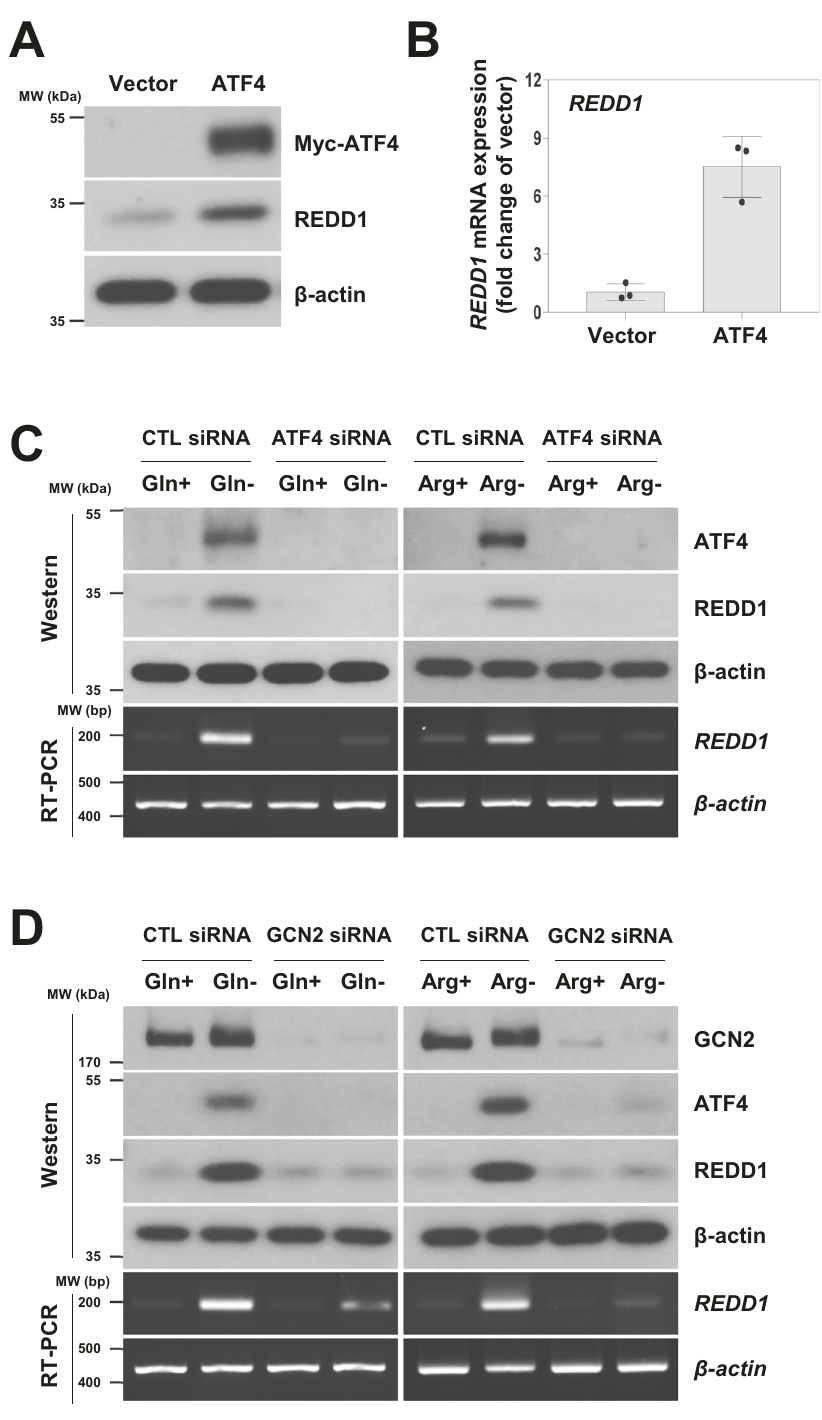
Fig. 2 The GCN2/ATF4 signaling pathway upregulates REDD1 expression upon glutamine or arginine deprivation. A , B H1299 cells were transiently transfected with an empty vector (pEF) or a myc-tagged mATF4 (ATF4) plasmid for 24 h. The indicated protein and mRNA expression levels were measured by western blot and real-time PCR analyses ( A , B ). The real-time PCR results for each sample were analyzed according to the 2 − ΔΔ Ct method using β ‑ actin as the internal control. REDD1 mRNA expression is presented as the fold change relative to the control sample ( n = 3). C , D H1299 cells were transfected with a control, ATF4 or GCN2 siRNA for 12 h and incubated in complete medium or medium lacking glutamine or arginine for 24 h. The indicated protein and mRNA expression levels were measured by western blot and RT- PCR analyses. CTL: In response to amino acid limitation, general control nonder- REDD1 induction upon glutamine or arginine deprivation (Fig. 2C), epressible 2 (GCN2) kinase senses intracellular amino acid levels suggesting that ATF4 activation is involved in the induction of and activates ATF4 during metabolic adaptation [9]. Hence, we REDD1 expression in response to glutamine and arginine investigated whether GCN2 is involved in the expression of ATF4 deprivation.